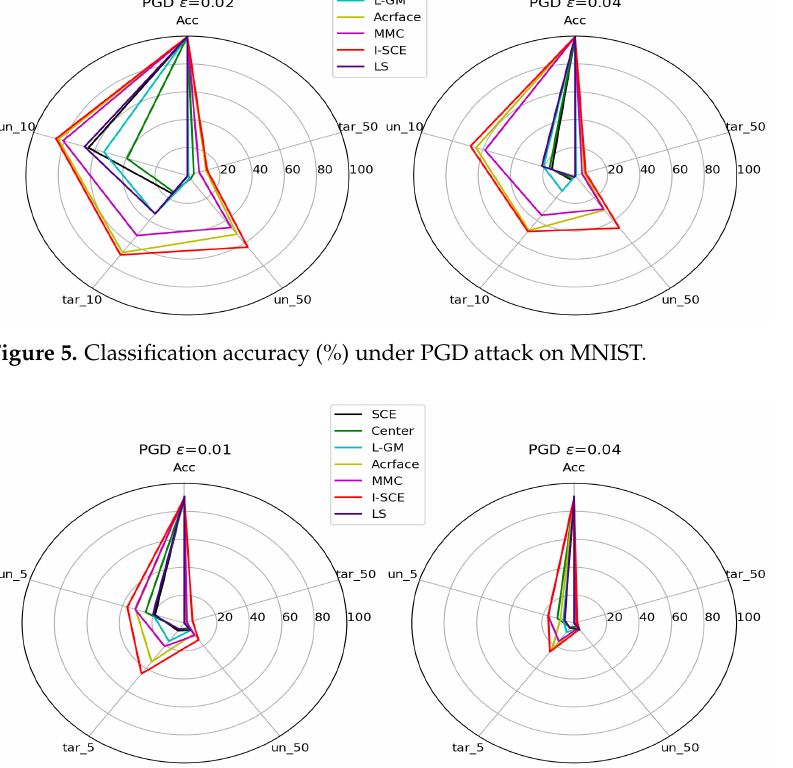
Figure 6. Classification accuracy (%) under PGD attack on CIFAR10.